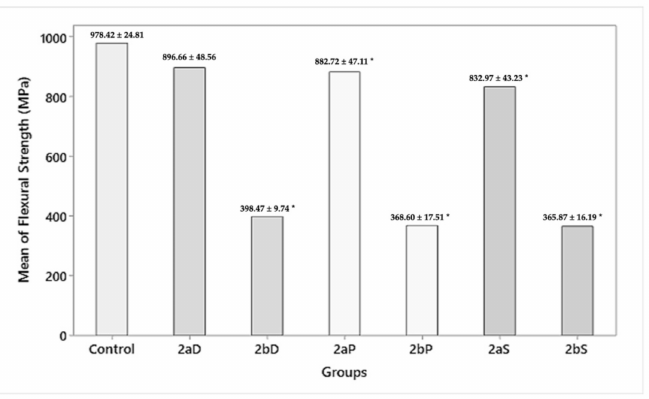
Figure 10. Flexural strength after polishing procedures (MPa). * Annotates significant differences. SEM images of sintered and abraded zirconia specimens are shown in Figure